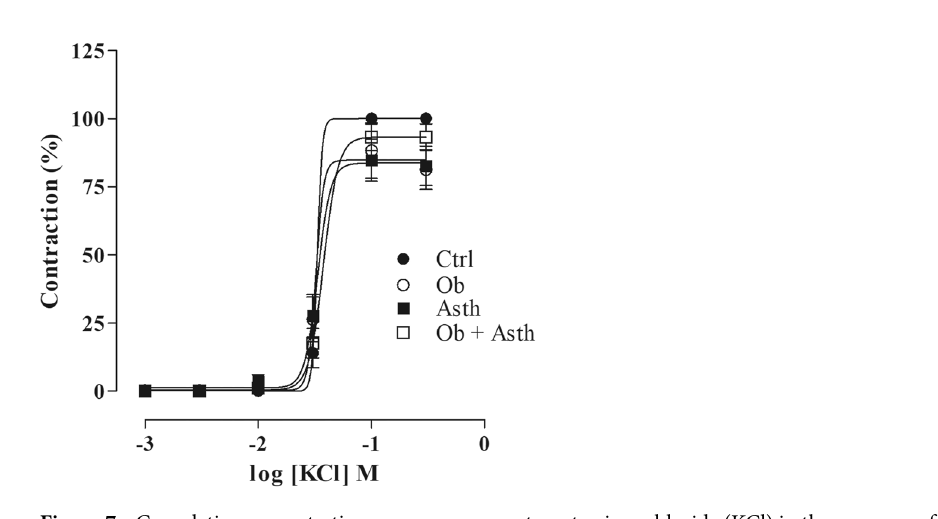
Figure 7. Cumulative concentration–response curves to potassium chloride (KCl) in the presence of functional epithelium in rat trachea. Symbols and vertical bars represent the mean and the e.p.m., respectively. One-way ANOVA followed by Tukey’s posttest (n =